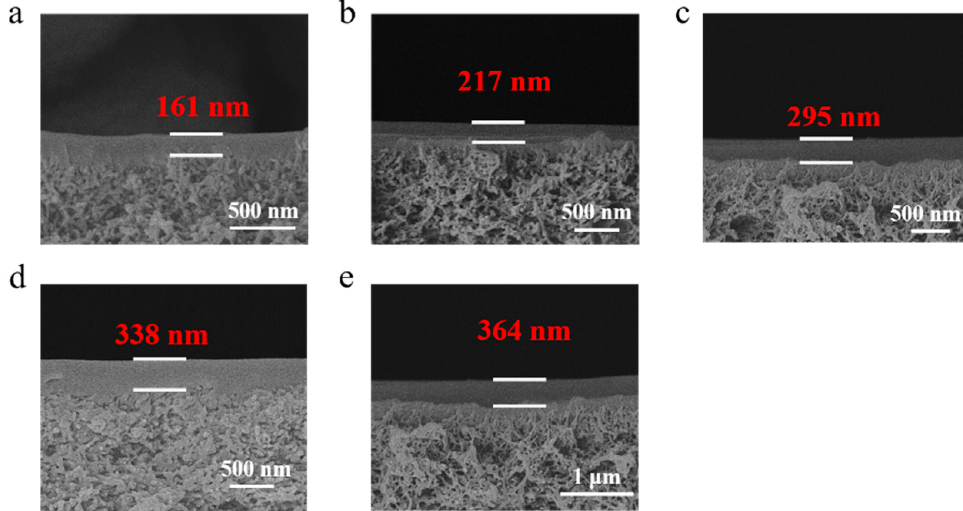
Figure 3. The cross-section topographies of the PPPS/PDMS/PSf composite membranes with different PDMS concentrations. The letters a~e respectively represent the concentration of PDMS used in membranes: 0.5 wt% ( a ), 1.0 wt% ( b ), 1.5 wt% ( c ), 2.0 wt% ( d ), and 2.5 wt% ( e ). The wet coating thickness is 300 μ m.